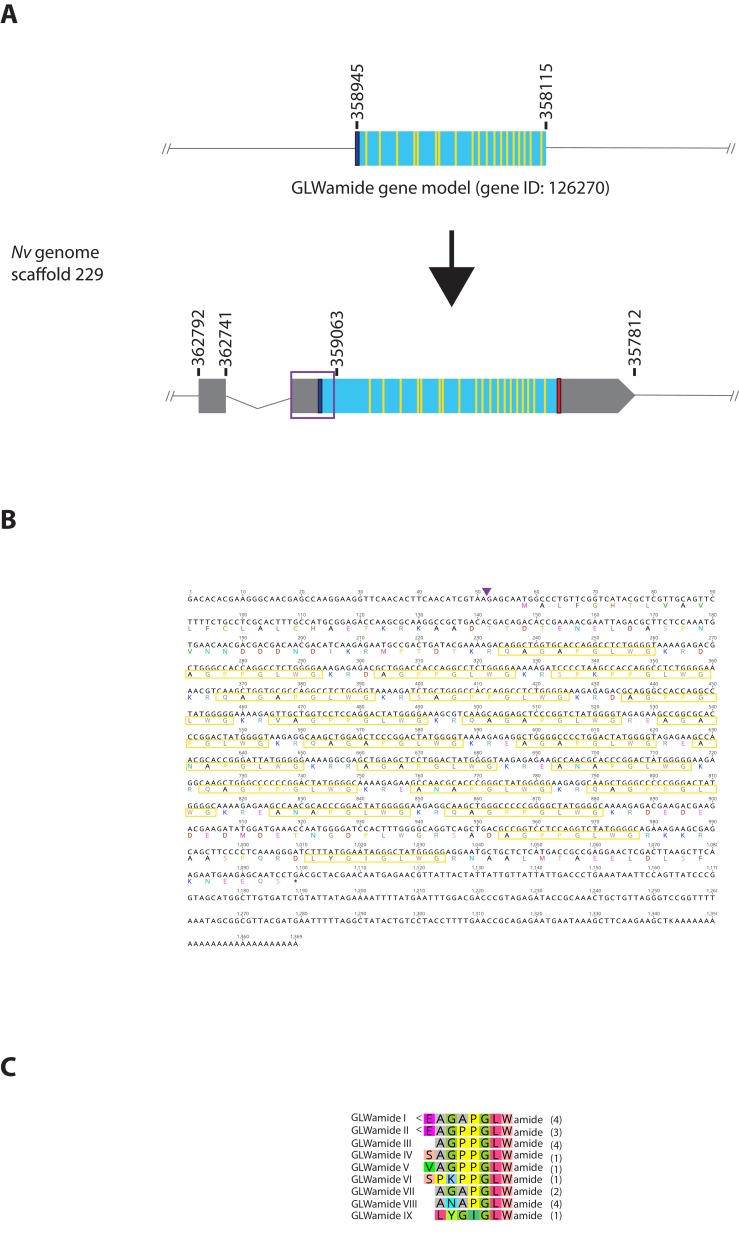
Genomic organization, cDNA sequences, and predicted mature peptides of GLWamide gene.(A) Schematic view of the GLWamide genomic locus, located in scaffolds 229 of the N. vectensis genome (v.1.0; http://genome.jgi.doe.gov/Nemve1/Nemve1.home.html). Gene structure based on gene model prediction is shown at the top, and the revised structure based on the comparison of the N. vectensis genome and cDNA sequences is shown at the bottom. The number above the schematic indicate genomic coordinates within the scaffold. Grey boxes are untranslated regions; aqua-colored boxes are translated regions. Blue bars show predicted translation start sites; red bars show predicted translation termination sites; yellow bars show predicted GLWamide-encoding regions described below. The region boxed in purple is missing in the currently available genome of N. vectensis (v.1.0). Note that the revised gene structure contains two exons. (B) cDNA and deduced amino acid sequence of the GLWamide gene. Short peptides that are either repeated or similar, and are likely to be released by proteolytic cleavages are circled in yellow. It is assumed that single or multiple acidic and basic residues become cleaved as suggested in another sea anemone Anthopleura elegantissima (Darmer et al., 1991; Leviev and Grimmelikhuijzen, 1995). A purple arrowhead indicates the intron position. (C) Amino acid sequence alignment for GLWamides I-IX. We assume that upon release of the peptide, an N-terminal glutamine is spontaneously converted into a pyroglutamic acid residue (<Glu), and a C-terminal glycine becomes amidated by an α-amidating enzyme (cf. [Darmer et al., 1991]). The numbers on the right of each peptide sequence indicate copy numbers of each peptide that a single precursor protein is predicted to generate.